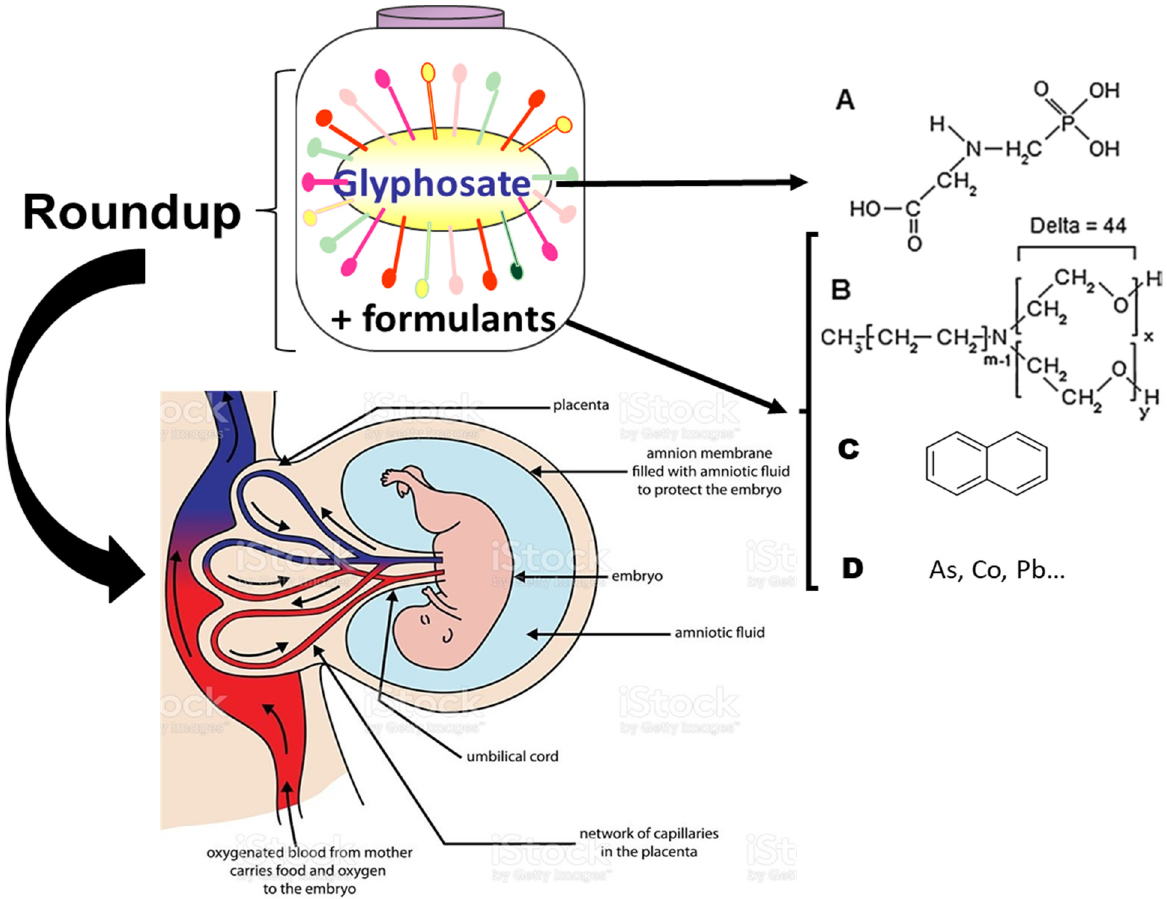
Figure 1. Roundup composition containing glyphosate and its formulants tested through human placenta. Roundup R is composed of a declared active principle glyphosate G ( A ) and other products (formulants) in the commercialised herbicide product, and evidenced more recently, such as polyethoxylated alkylamines POEA ( B ), naphtalene ( C ), and heavy metals ( D ). The transfer of R (with formulants) and G (without formulants) through the placenta ex vivo are studied here.